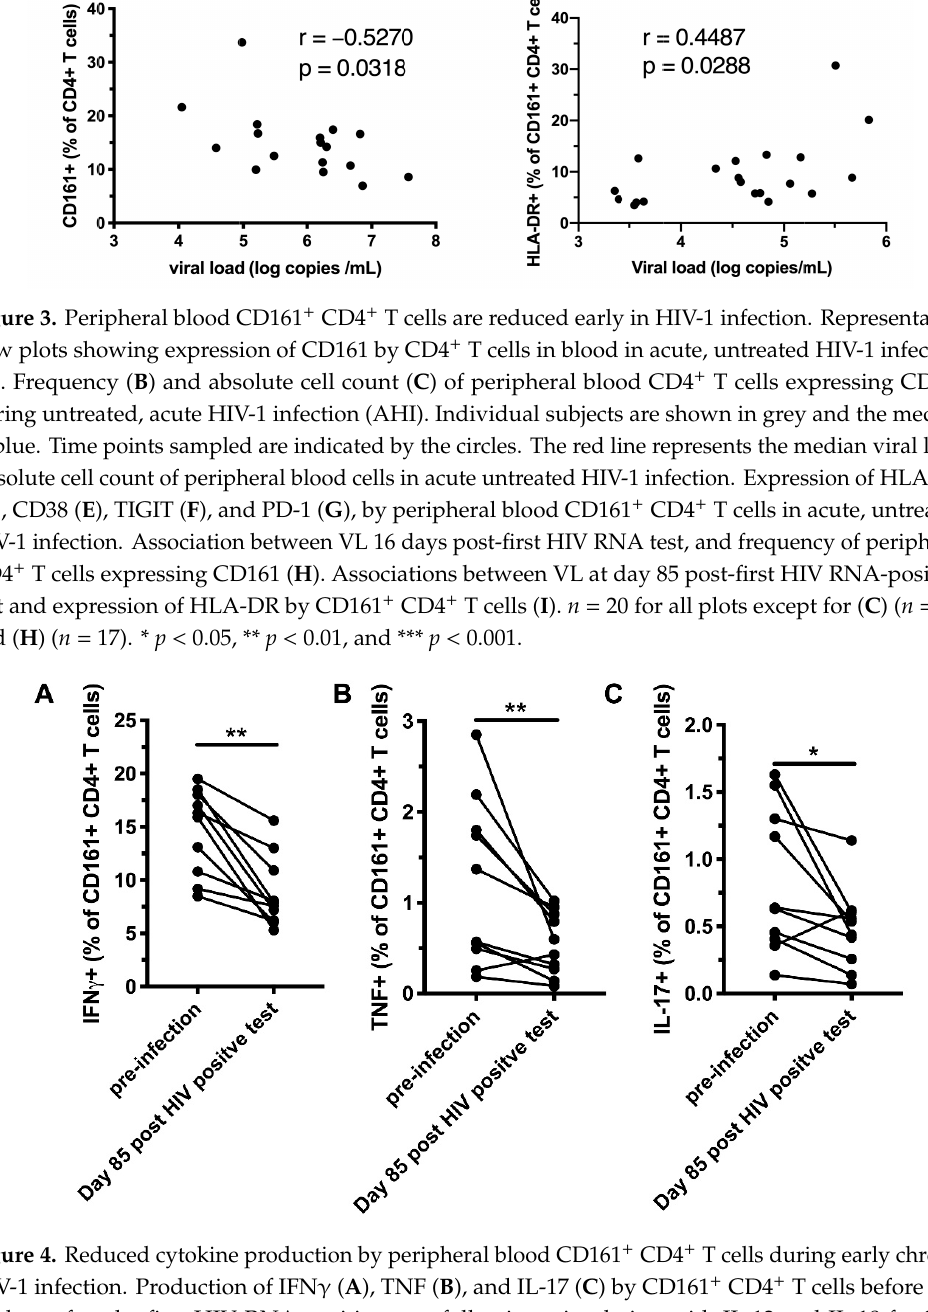
Figure 4. Reduced cytokine production by peripheral blood CD161 + CD4 + T cells during early chronic HIV-1 infection. Production of IFN γ ( A ), TNF ( B ), and IL-17 ( C ) by CD161 + CD4 + T cells before and 85